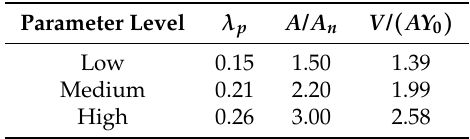
Table 3. Parameters levels for cones samples.